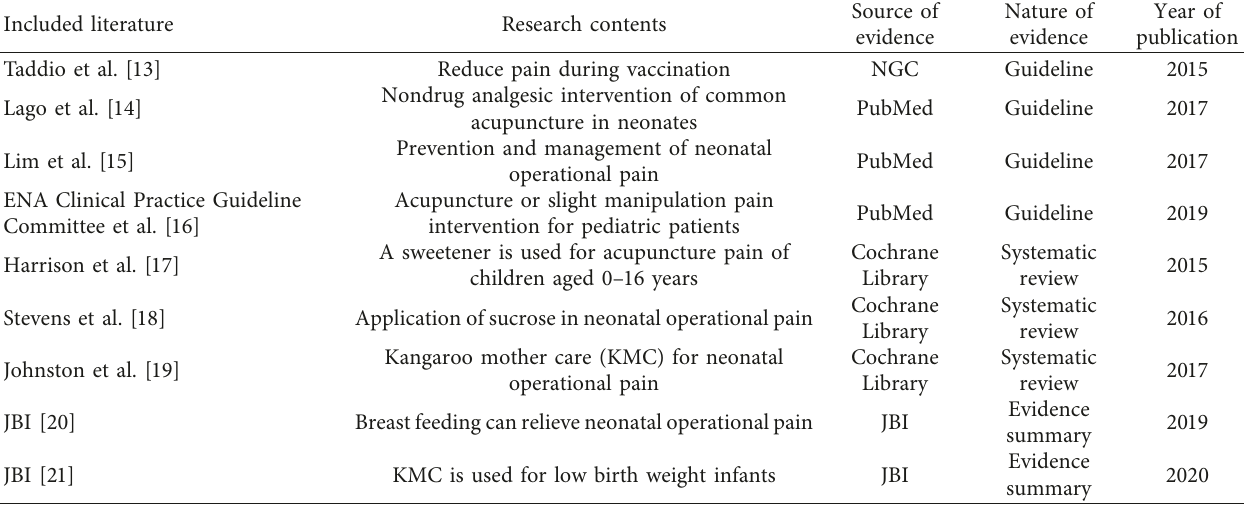
Table 1: Basic characteristics of the included literature works.